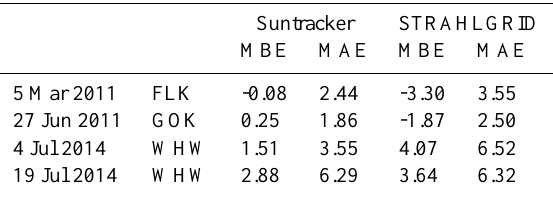
Table 4. Mean bias error (MBE) and mean absolute error (MAE) for corrected albedo values between modelled and measured data determined with reference measurement (Suntracker) and solar radiation model